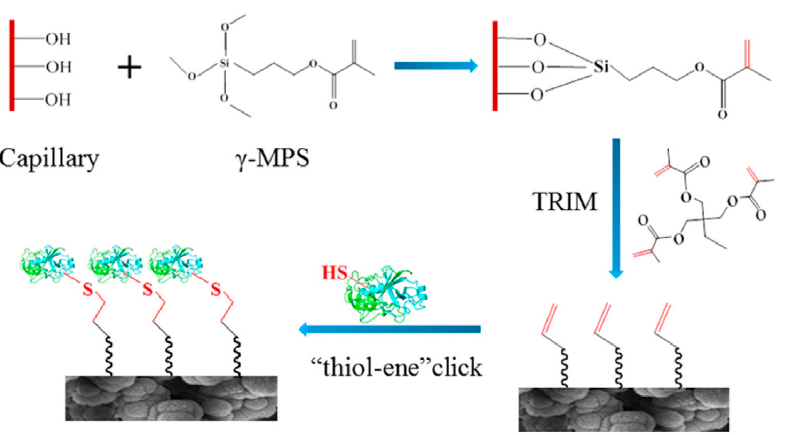
Figure 6. Reaction scheme of preparing a µ -IMER in a fused silica capillary containing methacrylate- based monolith. (Reprinted with permission from [54], published by Elsevier, 2020).